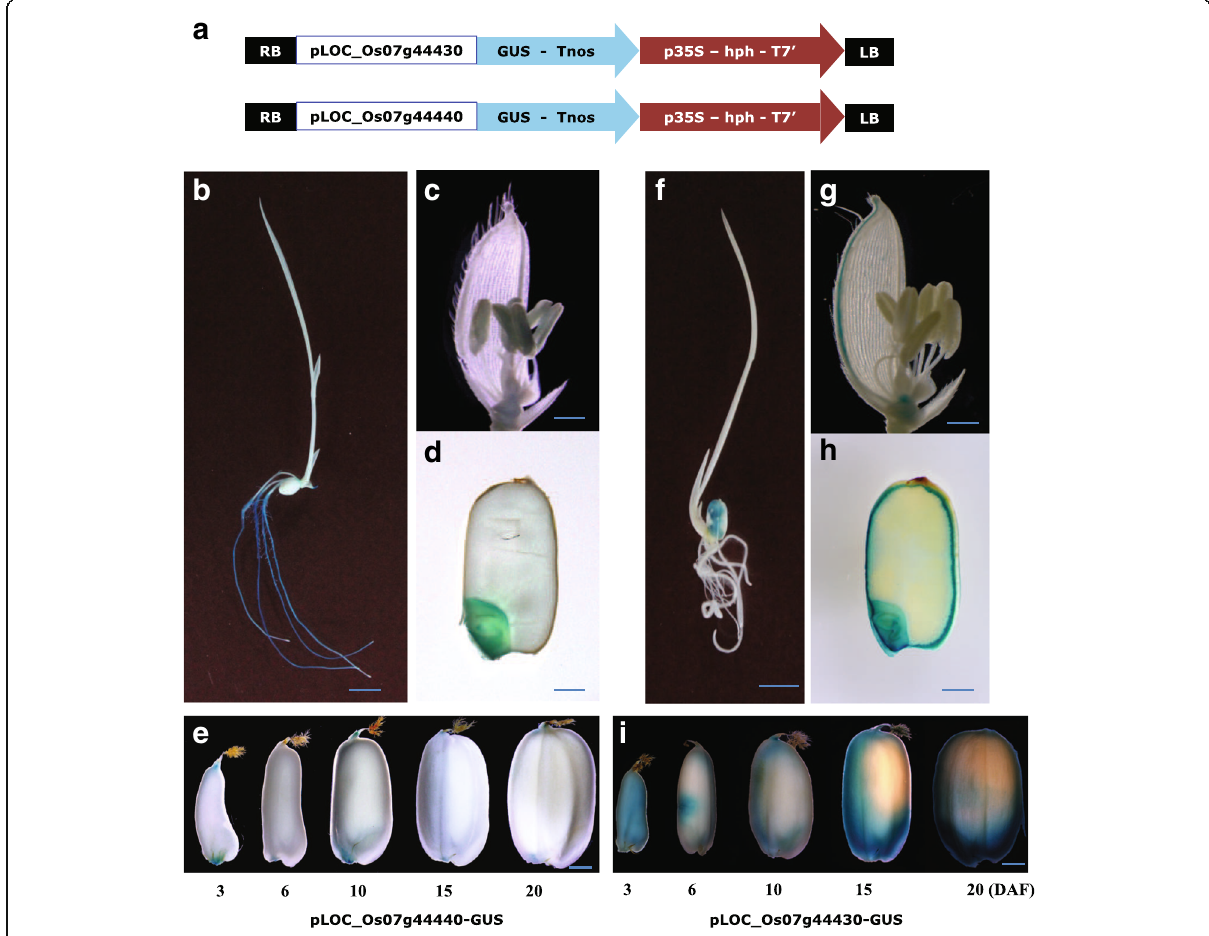
Fig. 3 Validation of differential expression patterns for two tandemly duplicated rice genes using GUS reporter system. a Maps of promoter – GUS vector for tandemly duplicated genes LOC_Os07g44430 ( upper ) and LOC_Os07g44440 ( lower ). b-e GUS activity in transgenic plant carrying pLOC_Os07g44440 – GUS vector, using samples from whole seedling ( b ), flower (c) , germinating seed (d) , and developing seed at 3, 6, 10, 15, and 20 DAP. ( e ). f-i GUS activity in transgenic plant carrying pLOC_Os07g44430 – GUS vector, using samples from whole seedling ( f ), flower ( g